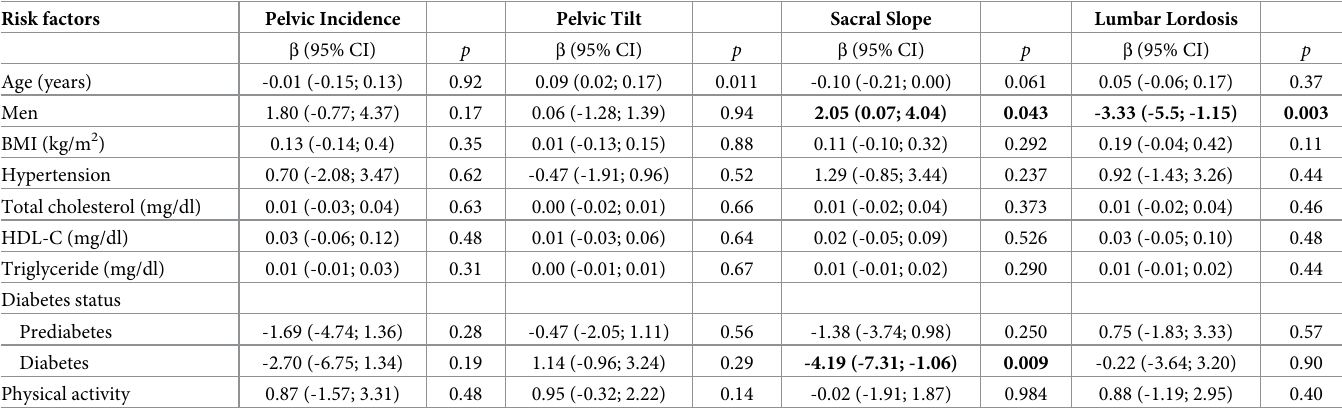
Table 3. Multivariable correlation of risk factors with spinopelvic